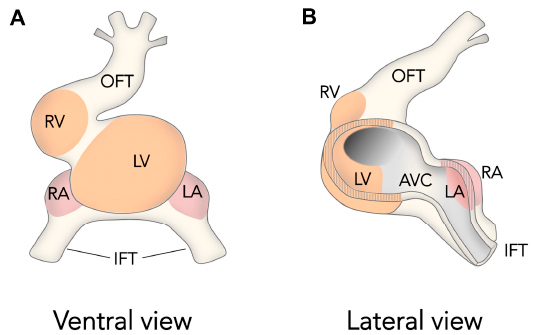
Figure 2. The ballooning Model for Cardiac Chamber Initiation. Schemes show ventral ( A ) and lateral–partially open–( B ) views of the looping amniote heart. The schemes are inspired in previous Figures published by Anton Moorman and colleagues [55]. Note how chambers develop at localized areas of the outer curvature of the heart tube and not form cylindrical segments of the heart tube. OFT , outflow tract, RV , right ventricle, LV , left ventricle, RA , right atrium, LA , left atrium, IFT , inflow tract, AVC , atrio-ventricular canal.